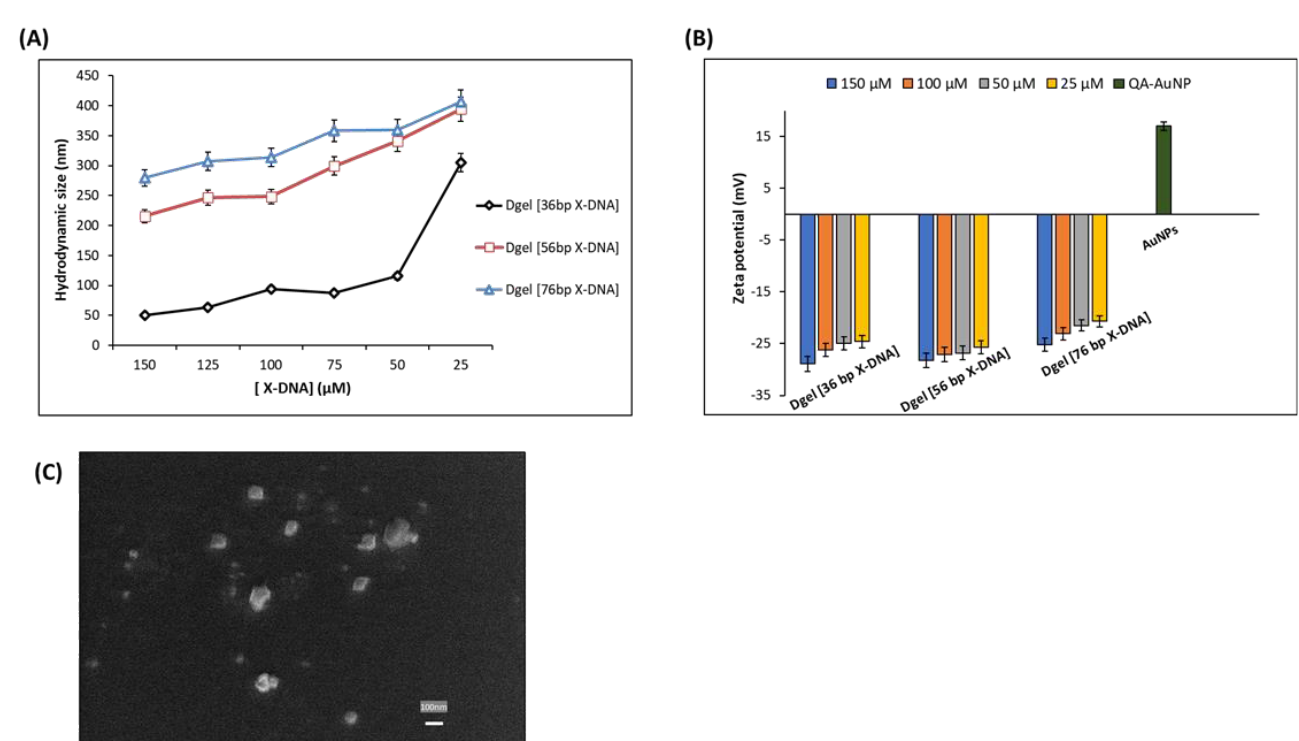
Figure 2. Physical properties of engineered Dgel scaffolds at varied X – DNA base pair sizes and concentrations. ( A ) DLS hydrodynamic sizes ( B ) Zeta potential studies ( C ) SEM image of (36 bp X – DNA engineered Dgel of [50 µM]).